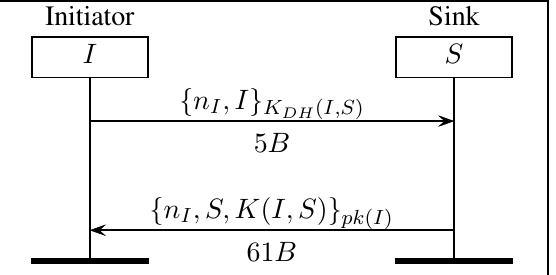
Figure 1. DJS : node I joins the network by communicating directly with the sink S .